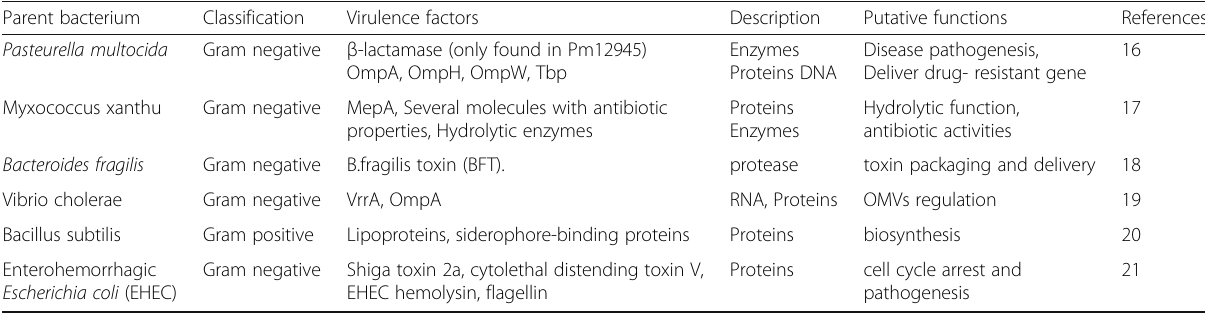
Table 1 Important virulence factors found in bacterial outer membrane vesicles Parent